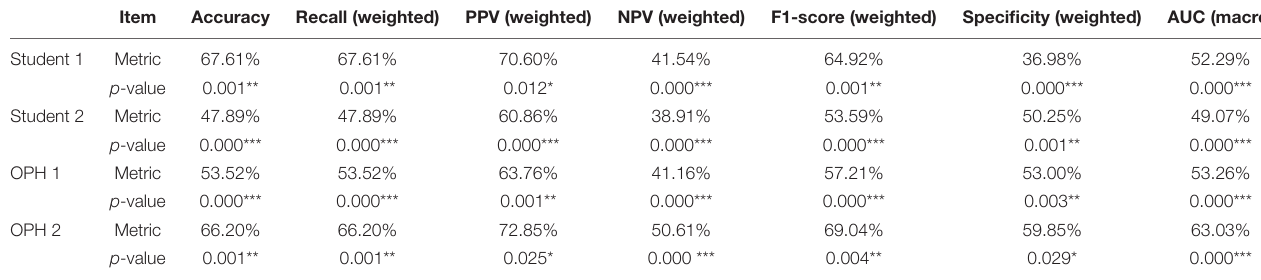
TABLE 8 | The comparison and test results in multiclass